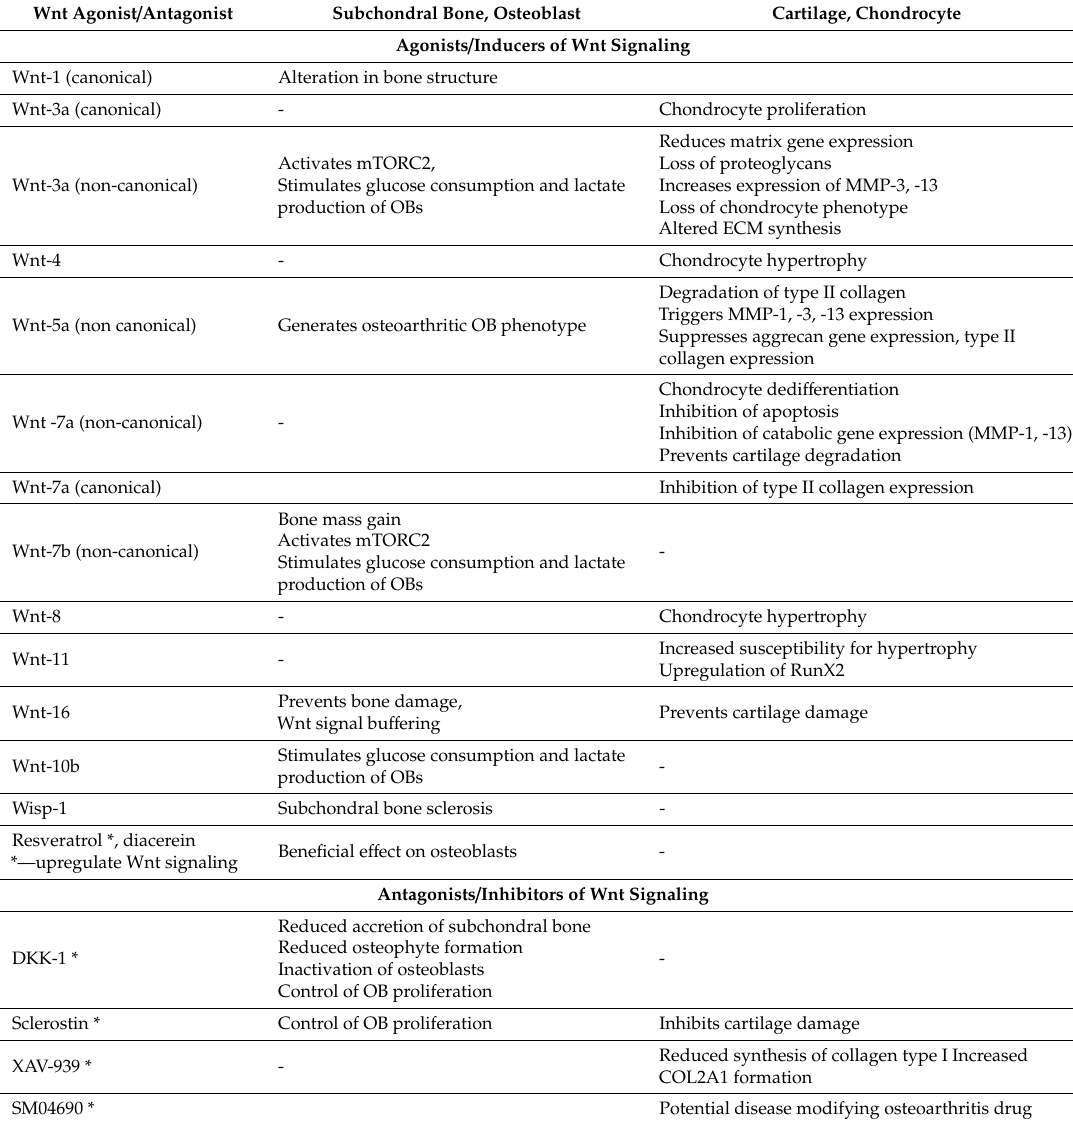
Table 1. Role of Wnt signaling pathway in subchondral bone and